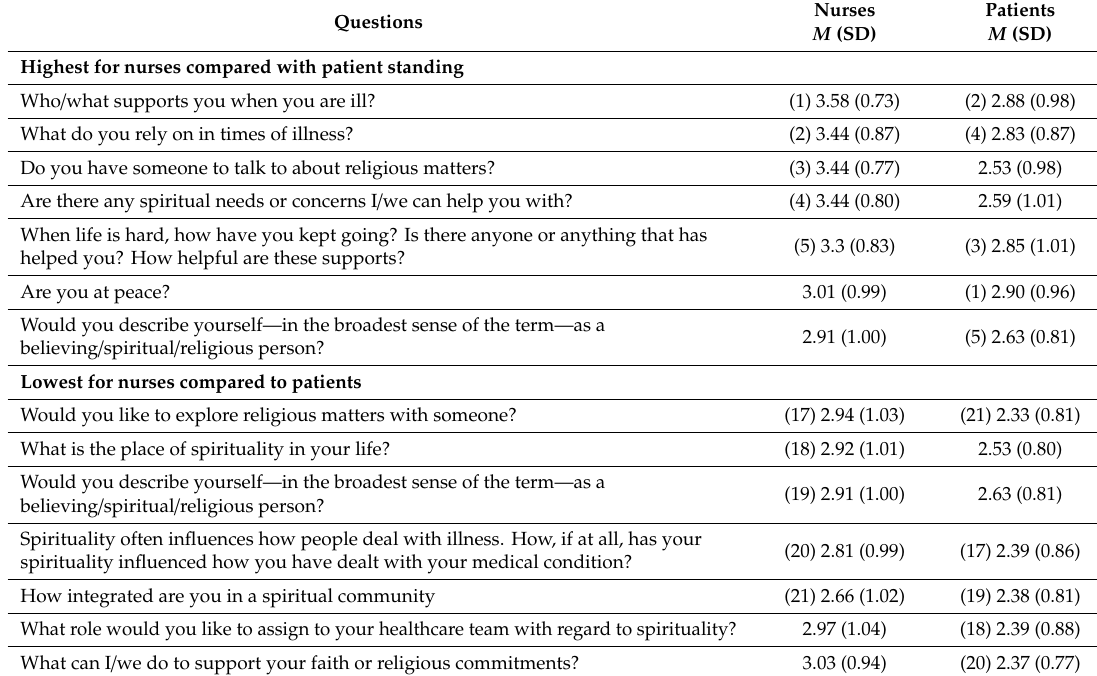
Table 3. Comparison of the highest and lowest scores on questions regarding comfort of spiritual assessment by nurses and patients, with means ( M ) and standard deviation